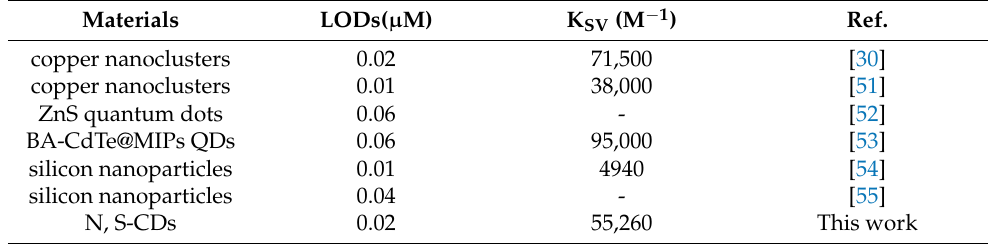
Figure 6. The schematic diagram for the fluorescence quenching process of N, S-CDs in the presence of rutin ( A ); the zeta potential of fluorescence quenching system ( B ); fluorescence lifetime of N, S-CDs in the absence and presence of rutin ( C ); fluorescent emission spectra of the N, S-CDs in the presence of different amounts of rutin ( D ); the dependence of the F 0 /F value on the different concentration of rutin (the inset was the Stern − Volmer plots) ( E ). Table 2. Comparison of the other reported optical materials for rutin detection.